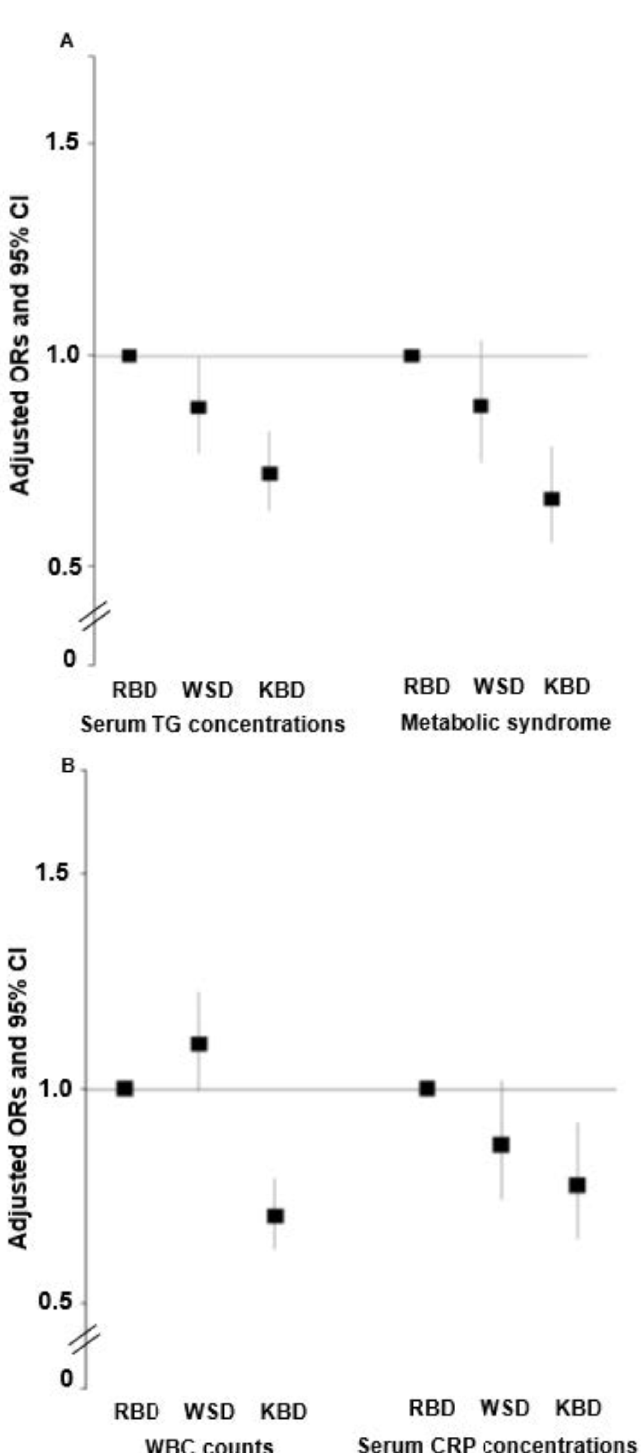
Figure 1. Adjusted odds ratio and 95% confidence intervals for metabolic syndrome and inflammatory indices according to dietary patterns. ( A ) Serum triglyceride concentrations and metabolic syndrome incidence. ( B ) Serum C-reactive protein (CRP) concentrations and white blood cell (WBC) counts. Adjusted covariates were age, gender, BMI, smoking and drinking status, and physical activity. The reference group was a rice-based diet (RBD). KBD, Korea balanced diet; WSD, Western-style diet.